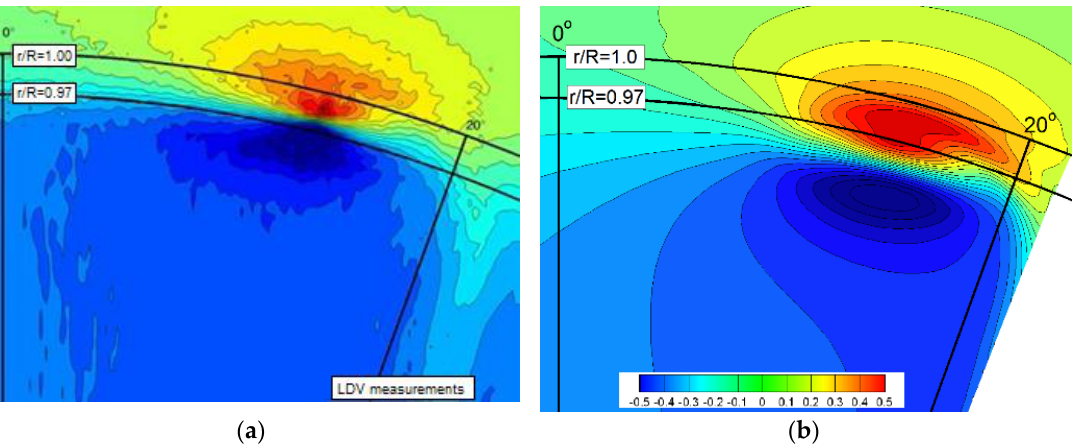
Figure 14. Comparison between the normalized axial velocities measured [44] and computed at x / D = 0.1. ( a ): measured values; ( b ): computed values. J. Mar. Sci. Eng. 2020 , 8 , x FOR PEER REVIEW